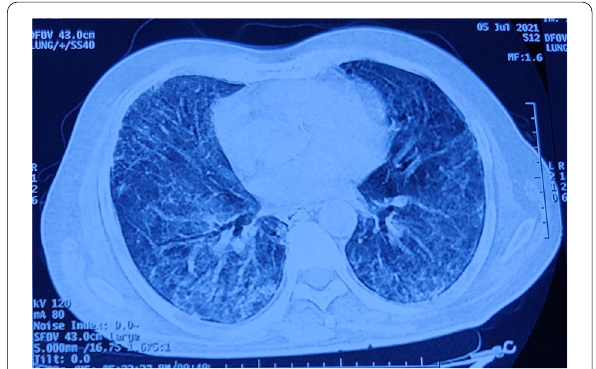
Fig. 2 HRCT-Chest showing diffuse areas of ground glass opacities and non-specific interstitial pneumonia